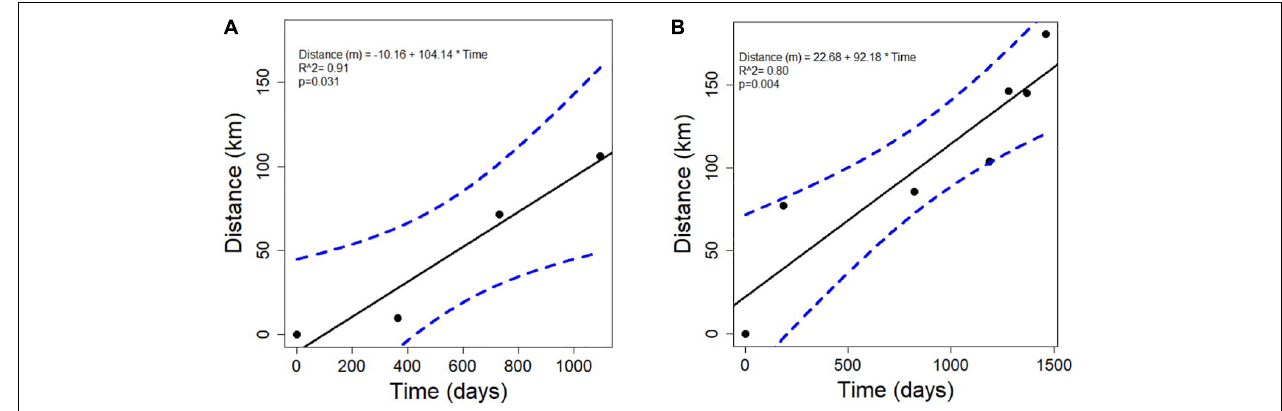
FIGURE 4 | The relationship between the time in days and the distance in kilometers that the stony-coral-tissue-loss disease progressed along the (A) north (annual points) and the (B) south (quarterly points) after the initial outbreak occurred in 2014 until June